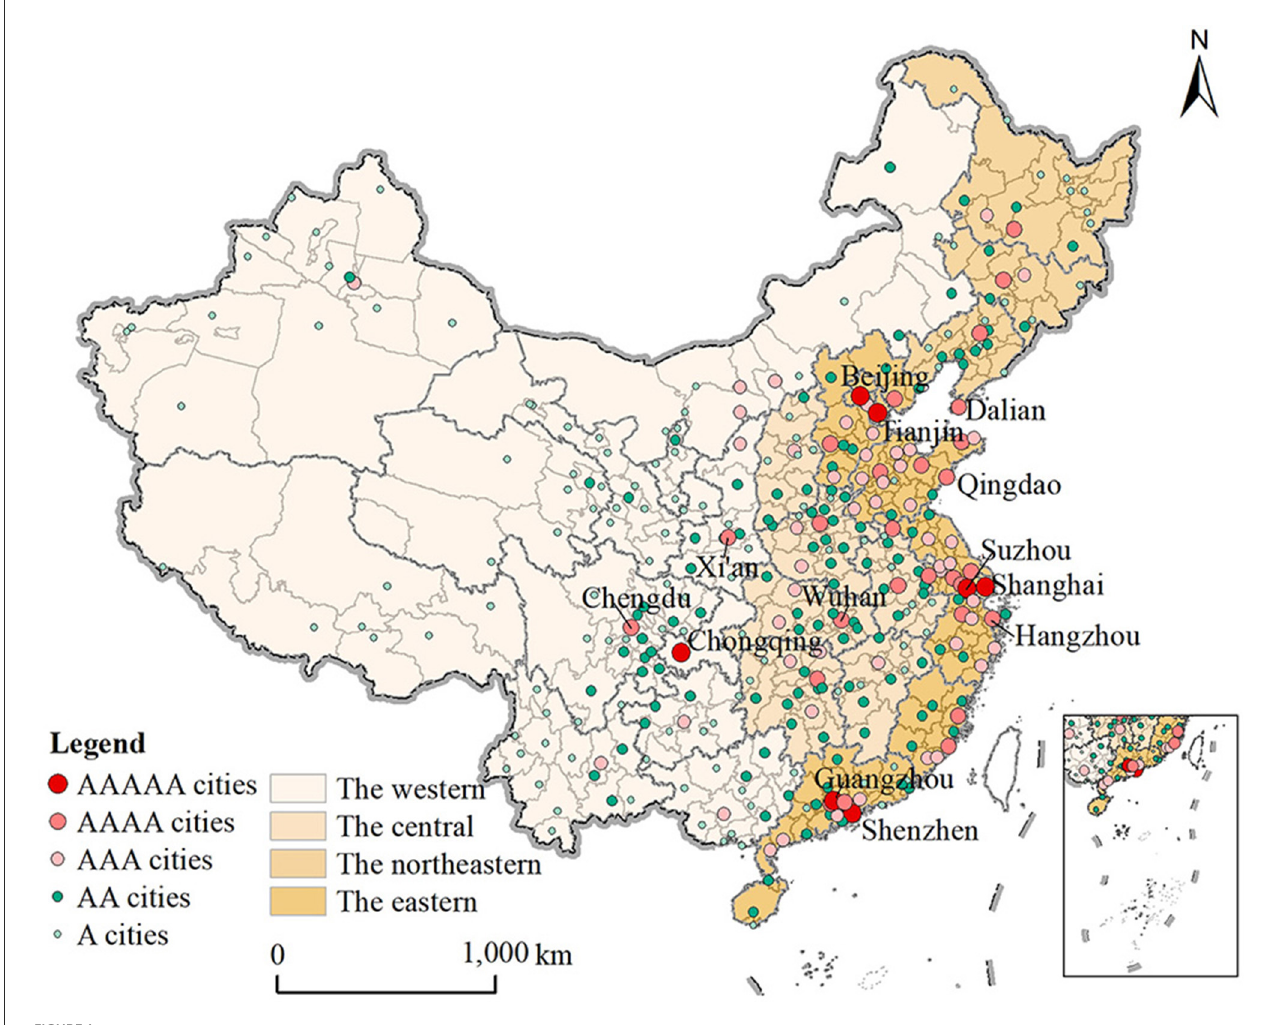
FIGURE1 The geographic location of four economic regions and the city hierarchy